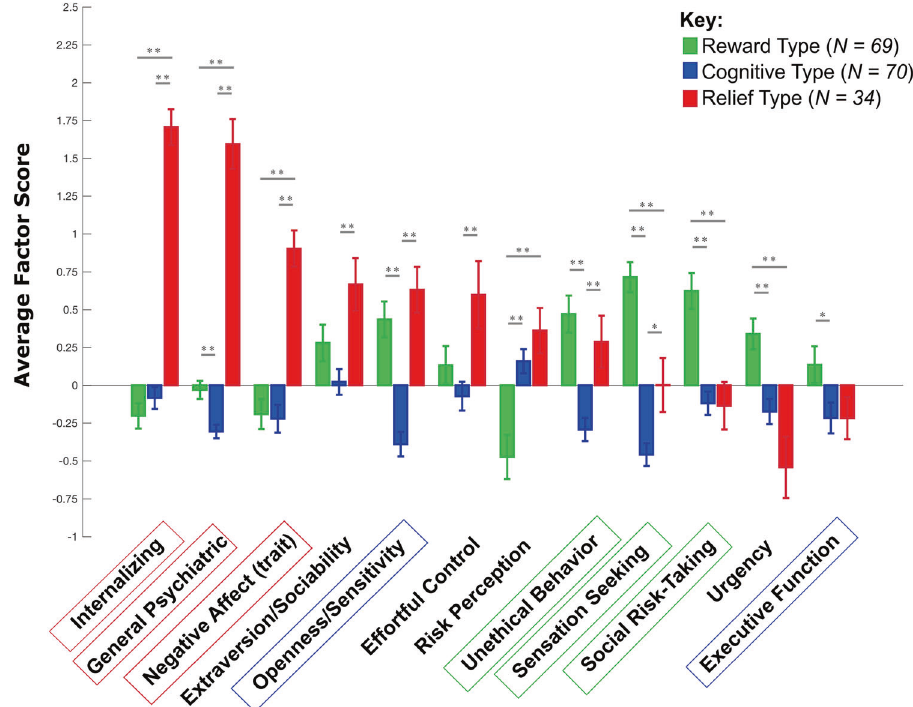
Fig. 2 Phenotypic pro fi les of the 3 subtypes. Subtypes were determined using latent pro fi le analysis on the EFA latent factors scores within individuals with past SUD diagnosis ( N = 173). Three subtypes were recovered, which included a Reward Type with higher sensation seeking, social risk-taking, and unethical behavior (green); a Cognitive Type with lower openness/sensitivity and a lower executive function (blue), and a Relief Type with higher internalizing, general psychiatric symptoms, and negative affect (trait) (red). Independent samples t-test were done to compare the subtypes statistically ( p < 0.05*, p < 0.01**). Error bars are standard